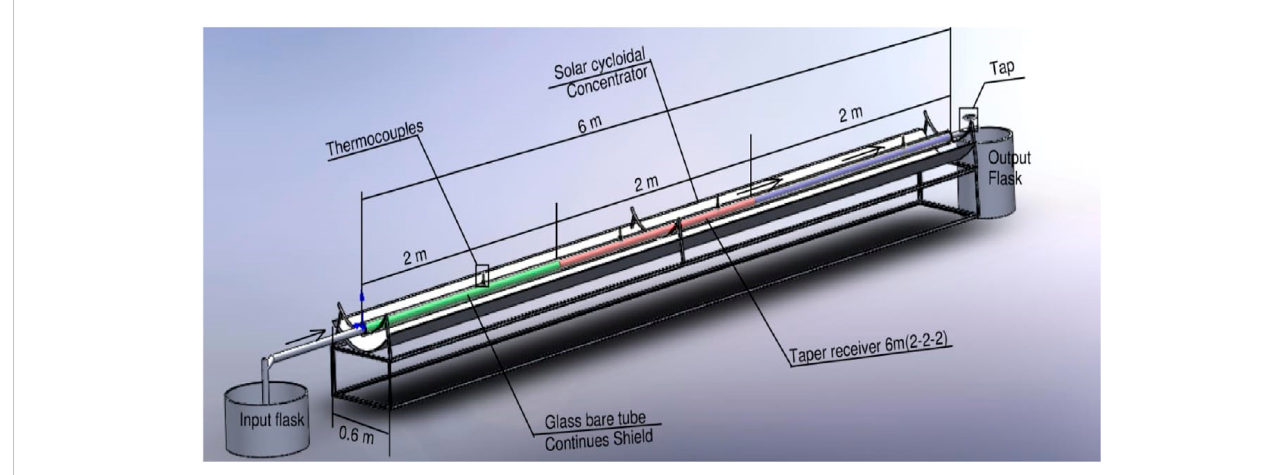
FIGURE 1 Setup of the solar cycloidal concentrator with a tapered receiver.